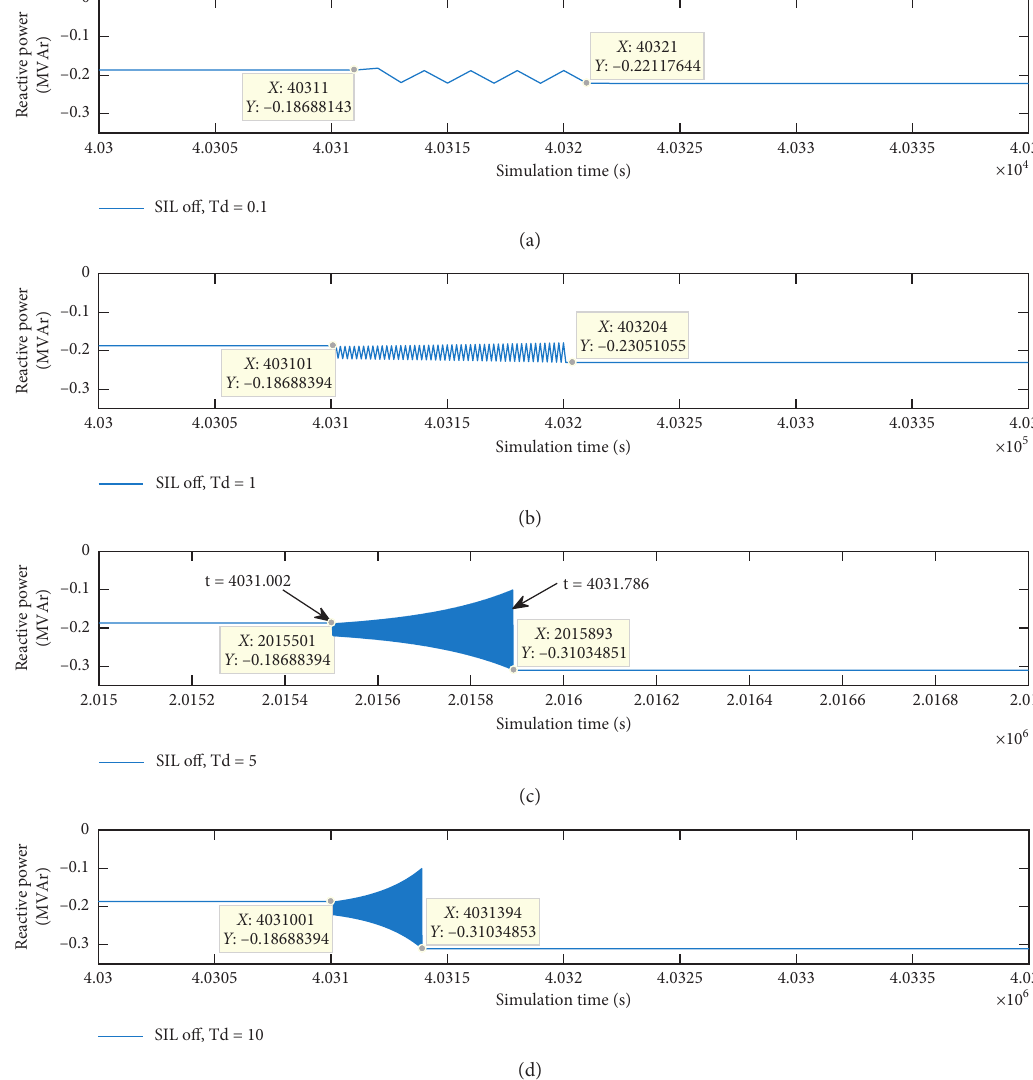
Figure 8: Results of the offline SIL simulations. Reactive power of the WTconverter when Td was 1, 0.1, 5, or 10. The possible “oscillation”